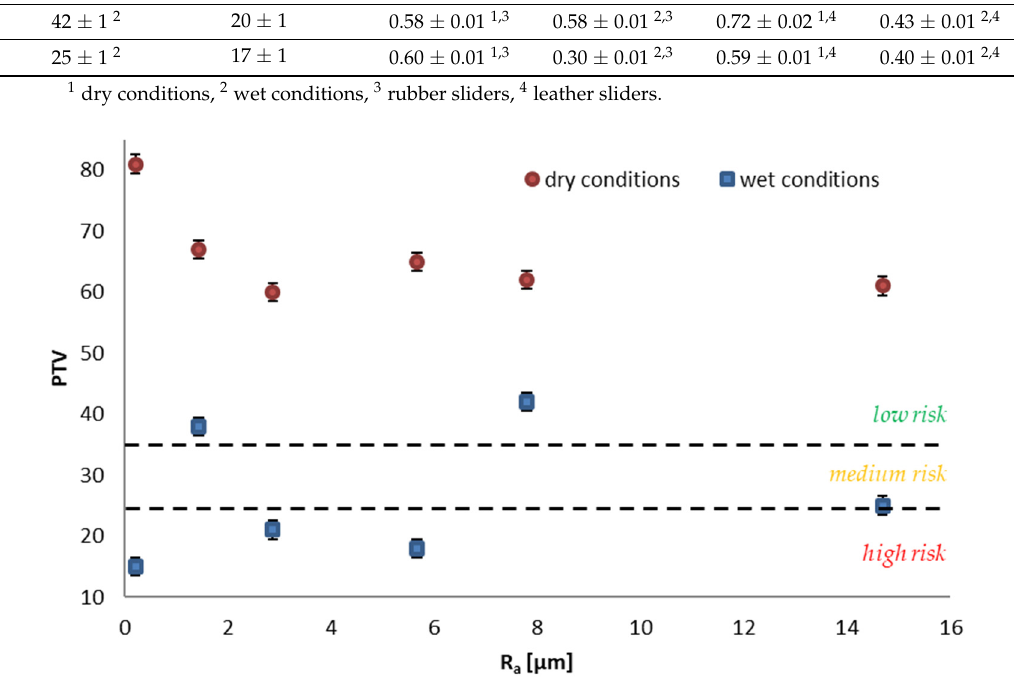
Figure 5. Slip risk classification according to Health and Safety Executive [27] depending on the roughness of surface in wet and dry conditions.